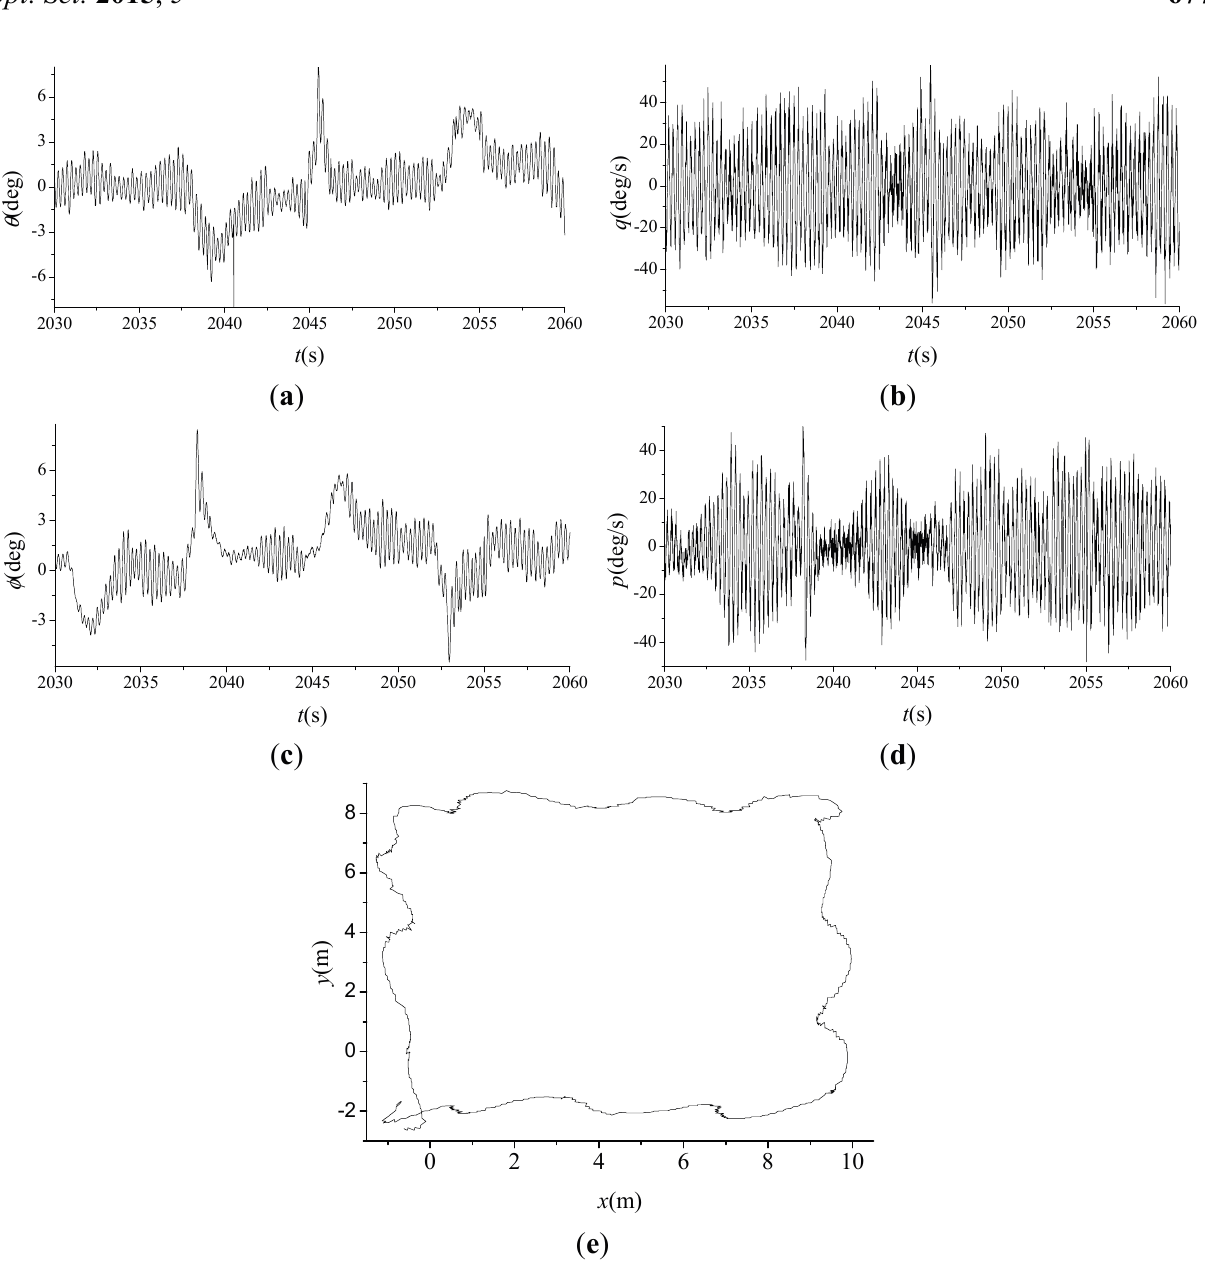
Figure 6. Test results of the conventional controller. ( a ) θ ; ( b ) q ; ( c ) φ ; ( d ) p ; ( e ) The ground track view of